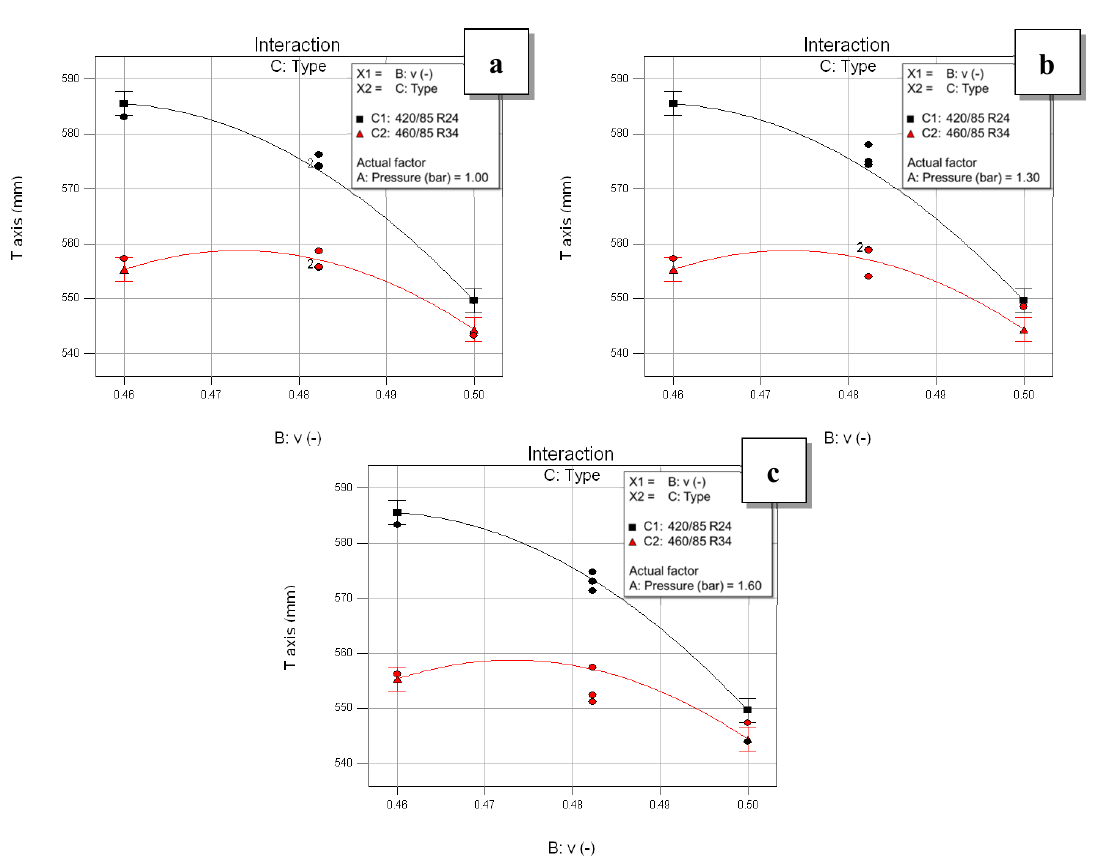
Figure 12. 2D representation of the interpolation models for the footprint transversal axis of the two tested tyres (black line: 420/85 R24; red line: 460/85 R34) as a function of Poisson’s ratio and at three tyre-inflating pressures: ( a ) 1.0 bar; ( b ) 1.3 bar; ( c ) 1.6 bar. FEM results are also represented in the pictures as round points.